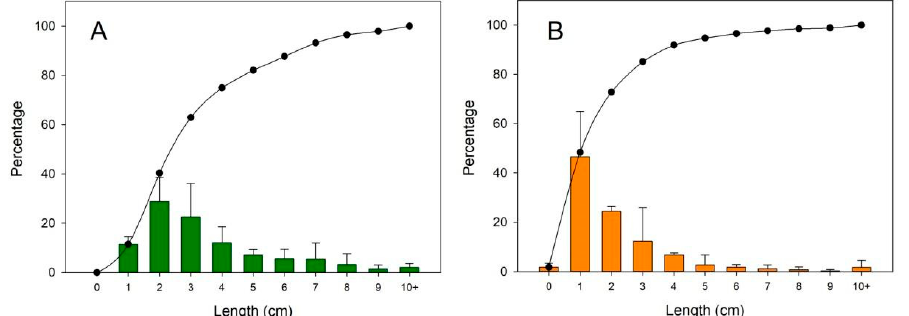
Figure 2. Histograms of the lengths of sampled individuals according to two different land use: ( A ) in green corresponds to Extensive Ranching systems and ( B ) in orange corresponds to Urban systems. The curve represents the cumulative percentage of individuals of each size. In all cases individuals longer than 10 cm were included in the last category.